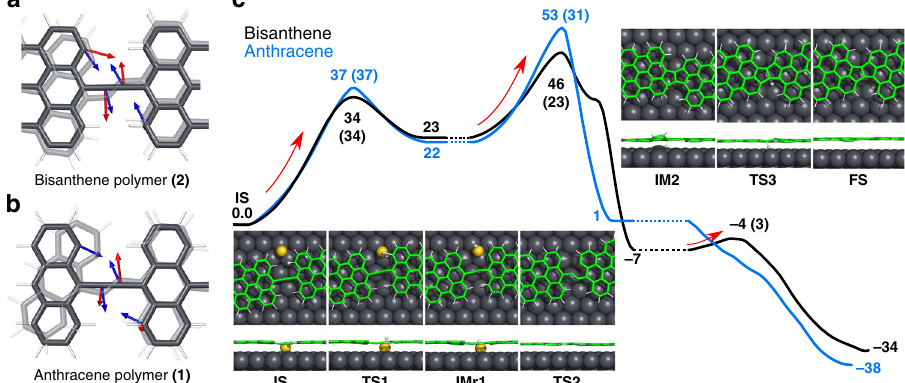
Fig. 2 Calculated vibrational modes and reaction pathways of polymers (1) and (2) on Au(111). a , b Comparison of calculated vibrational mode (red arrows) with reaction coordinates (blue arrows) for a , cumulene-like bridged bisanthene polymer ( 2 ) and for b , ethynylene-linked anthracene polymer ( 1 ). The atomic arrangement of the transition state ( TS2 ) is showed in transparent mode. Reaction coordinates are de fi ned as the displacement from the initial ( IMr1 ) to the transition state ( TS2 ) for the cyclization reaction pathway from IMr1 to IM2. c Free energy barriers (in kcal mol − 1 ) for the optimal reaction pathway calculated for anthracene ( 1 , blue) and bisanthene ( 2 , black) polymers at 650 K. Values of the activation energies are presented in brackets. Inset fi gures show top and side views of the initial state ( IS ), transition states ( TS ), intermediates ( IM ) and fi nal states ( FS ) of bisanthene polymer ( 2 ) optimal reaction pathway towards pentalene-bridged bisanthene polymer ( 3